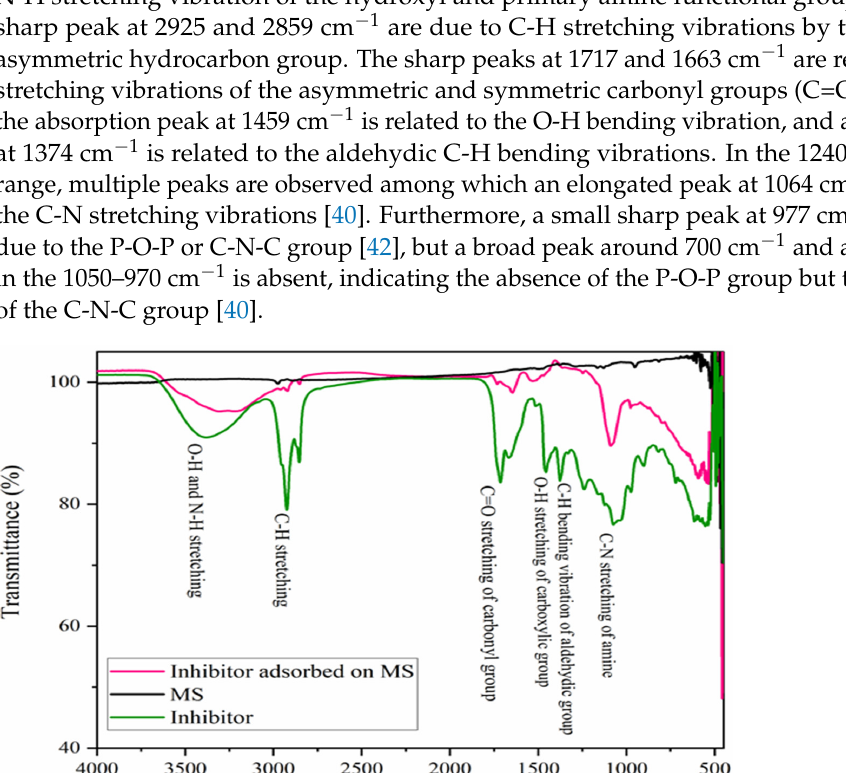
Figure 4. UV-Spectra of the alkaloids extracted from Ageratina adenophora stem.